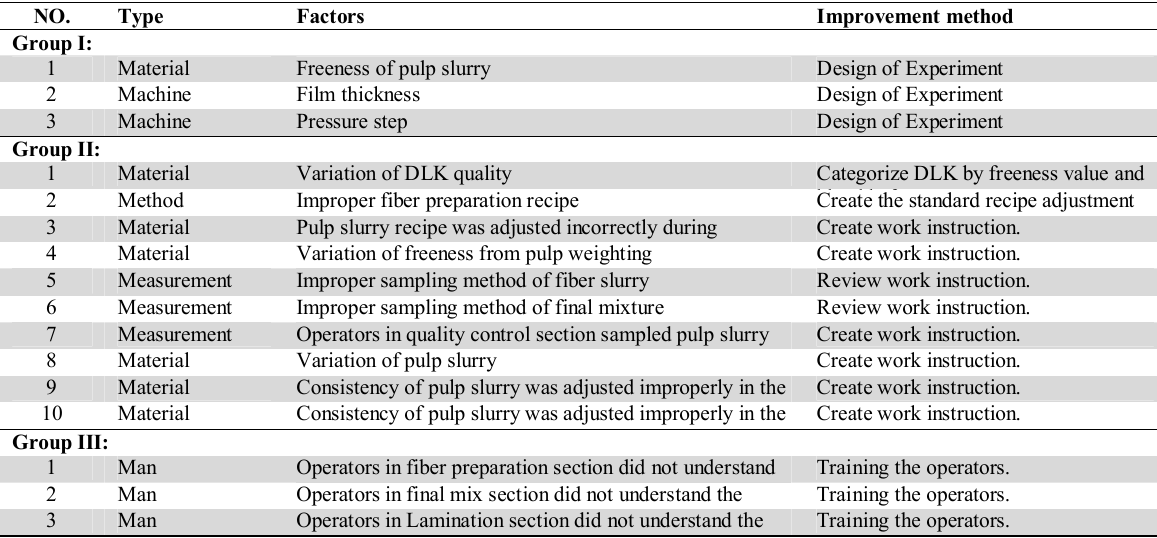
Description of selected